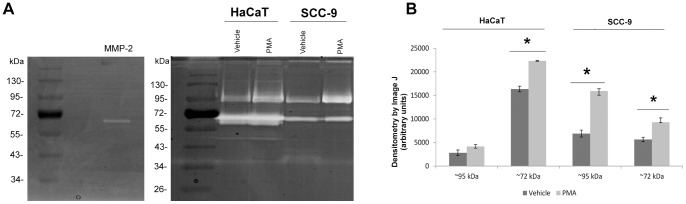
Gelatinase activity was increased with PMA stimuli.Representative 1D-zymography of conditioned media (12 µg of proteins) of HaCaT and SCC-9 cells treated or not with 50 ng/ml PMA two times with 12 h interval, collected after 24 h. The gelatinase activity of immunoprecipitated MMP-2 was used as positive control. Numbers on the left indicate the molecular mass marker mobility (A). The densitometry of clear areas showed the increase of activity after PMA treatment (B). Columns represent mean ± SD (n = 3) and * indicates p<0.05.